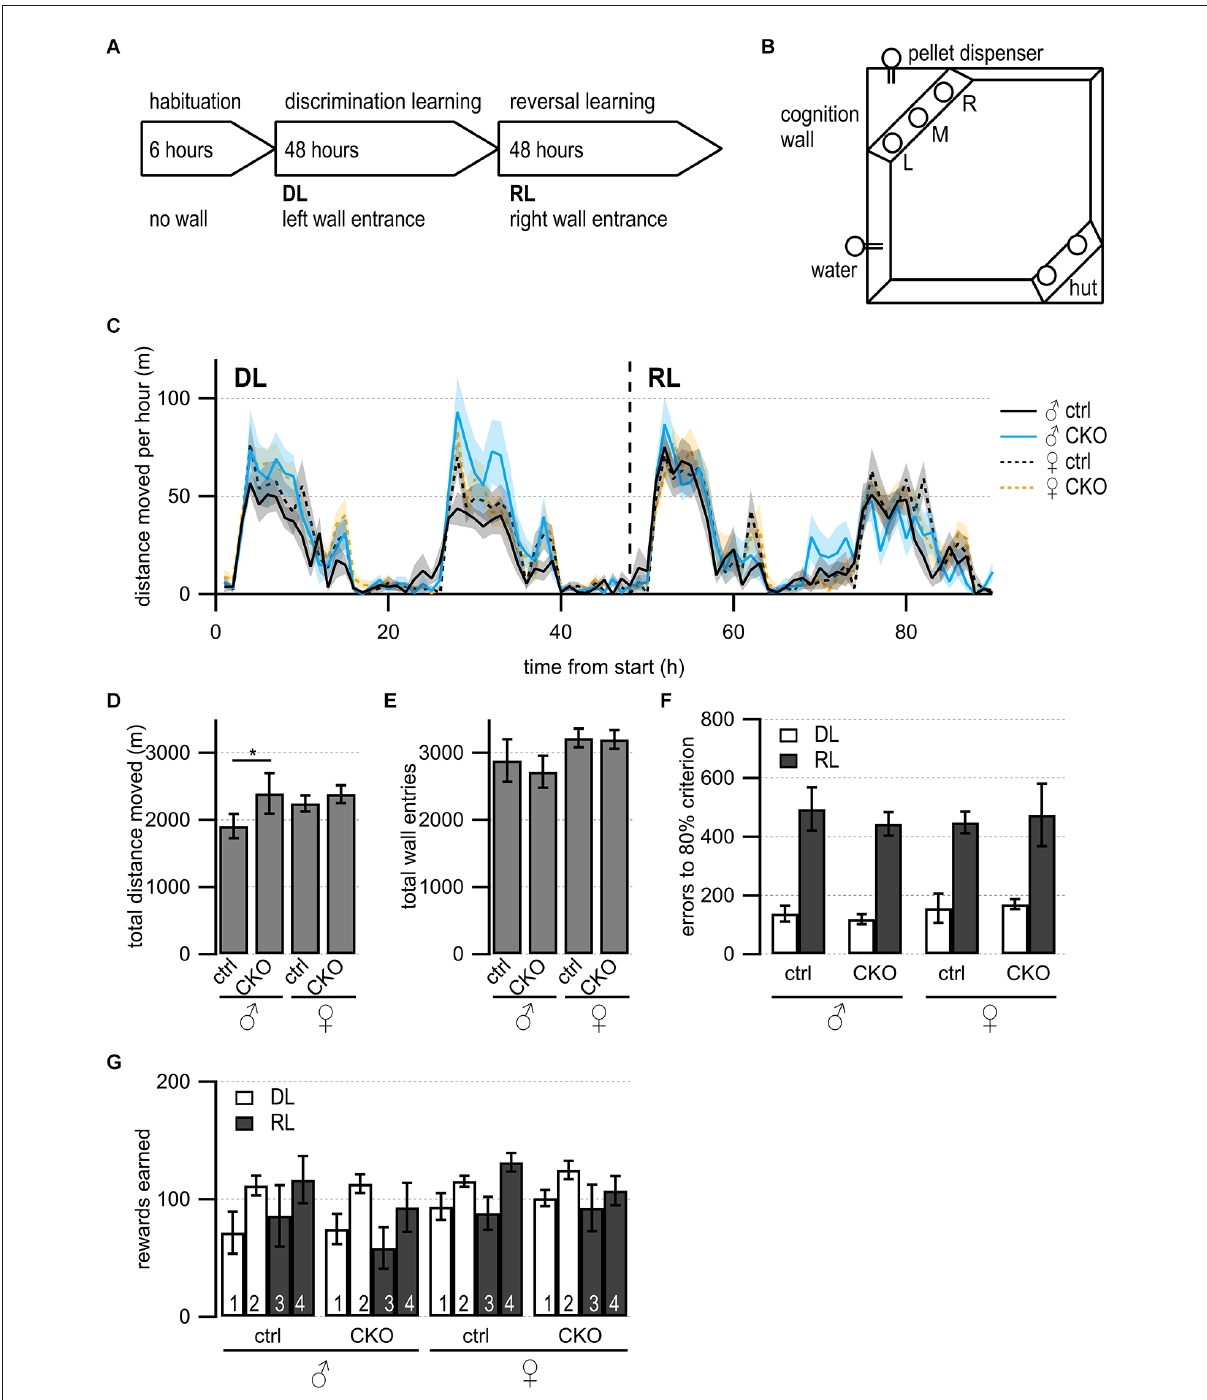
FIGURE4 Loss of GABA co-transmission from ACh neurons results in increased locomotion in males but no impairments in discrimination or reversal learning. (A) Timeline of Cognition Wall experiment. Habituation phase for 6 h without Cognition Wall. Introduction of the Cognition Wall ∼ 30 min before the start of discrimination learning phase (DL) for 2 days followed by reversal learning phase (RL) for another 2 days. During DL, the animal trained to enter left wall entrance for food reward. During RL, the animal trained to enter right wall entrance for food reward. (B) Cognition Wall setup. Hut for shelter in bottom right, water bottle in bottom left, Cognition Wall in top left covering the food dispenser. Left (L), middle (M), right (R) entrance of Cognition Wall. (C) The total distance moved during experiment per 1 h bin. (D) The total distance moved during experiment. (E) The total wall entries during experiment. (F) The number of error entries before reaching 80% learning criterion during DL and RL. (G) The number of reward pellets earned per day during DL and RL. Values represent mean ± SEM. Two-way ANOVA followed by Fisher’s protected least-significant difference (* p < 0.05). See Supplementary Table 5 for